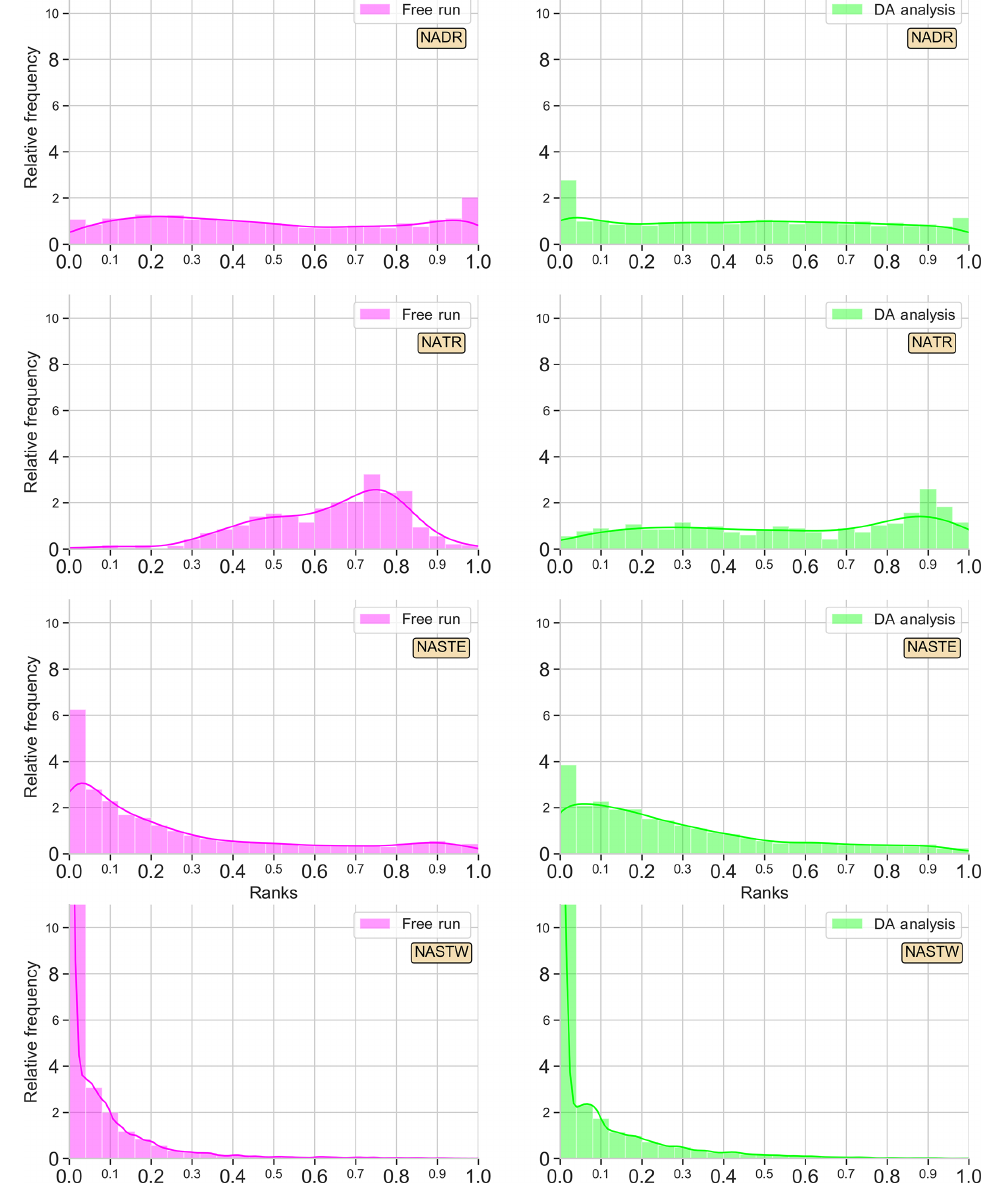
that the ensemble is unable to cover the lowest